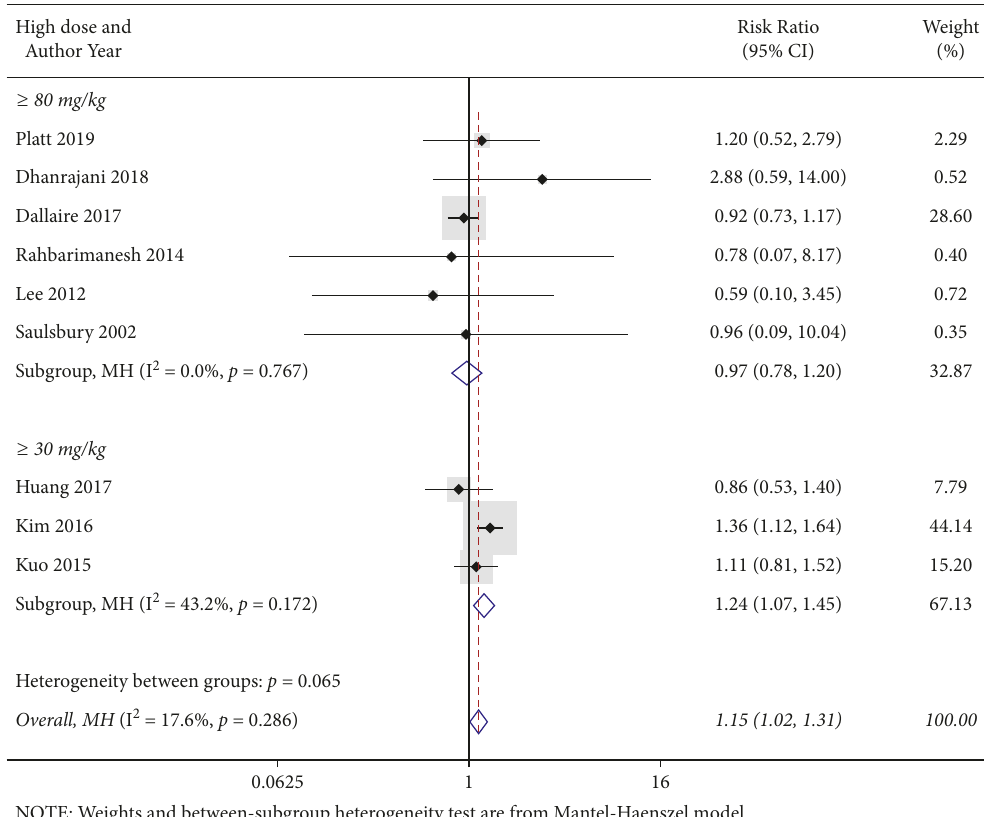
Figure 3: Subgroup analysis based on different dosages of aspirin in high-dose groups.